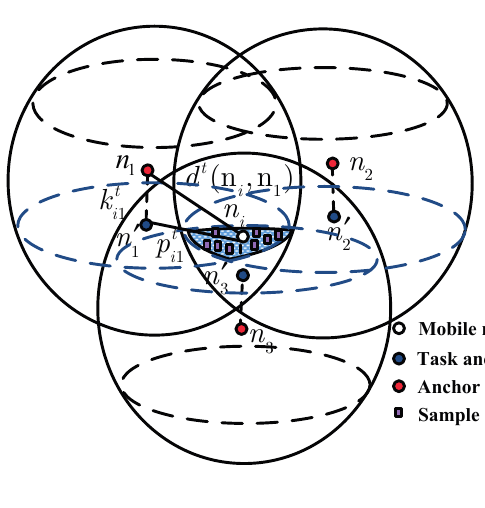
Figure 3. The sampling